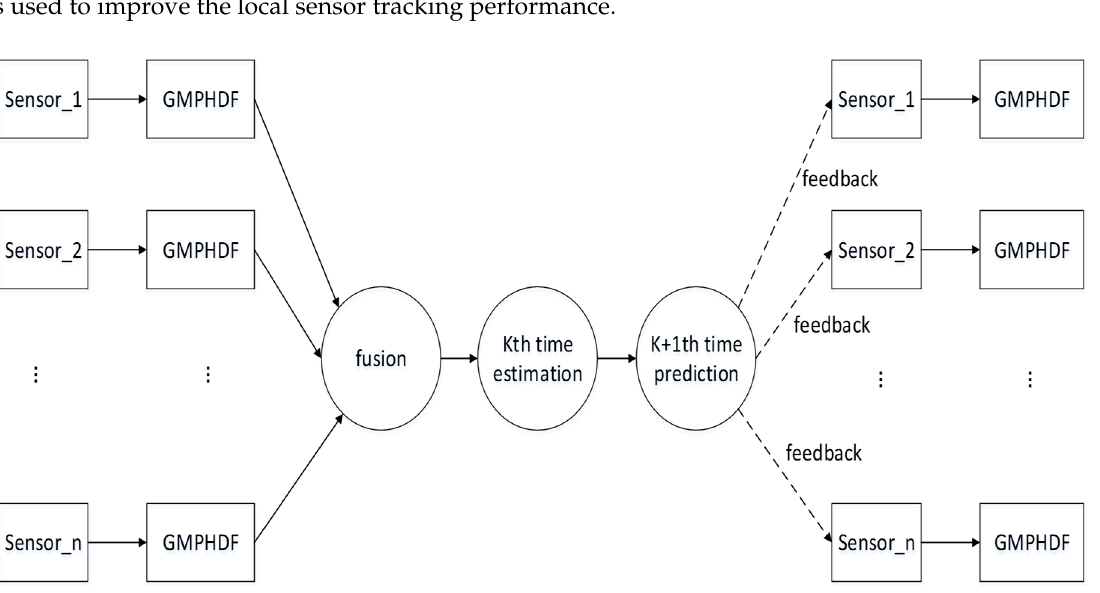
Figure 4. Framework of the maximum-detection capability multitarget track algorithm.